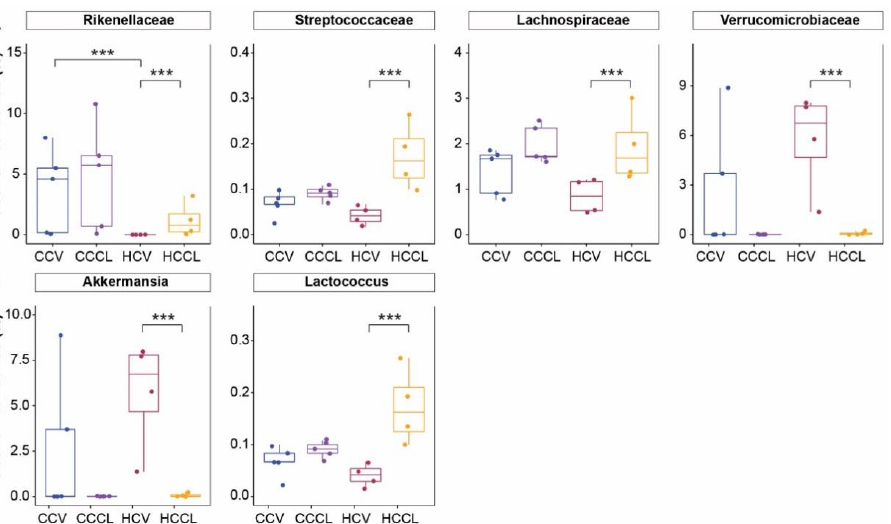
Figure 4. Family- and genus-level differences across treatments. Relative abundance of specific ( A ) families and ( B ) genera. CCV = offspring of control diet-fed dams treated with vehicle (n = 5); CCCL = offspring of control diet-fed dams treated with CL316,243 (n = 5); HCV = offspring of high-fat diet-fed dams treated with vehicle (n = 4); HCCL = offspring of high-fat diet-fed dams treated with CL316,243 (n = 4). Nonparametric multiple comparisons (*** p < 0.001).